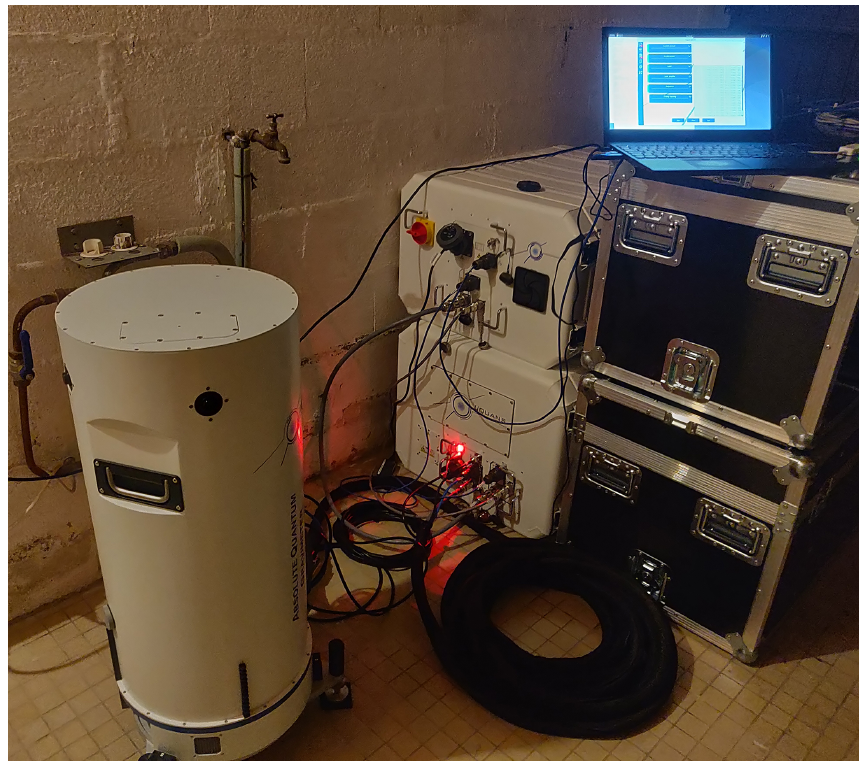
Figure 1. AQG-B01 in a garage in Montpellier in June 2020. The sensor head (left) is connected with the laser and electronic systems by 5m of cables. The AQG GUI software is used on a laptop to control the measurement as well as to correct, visualize, and analyse the gravity